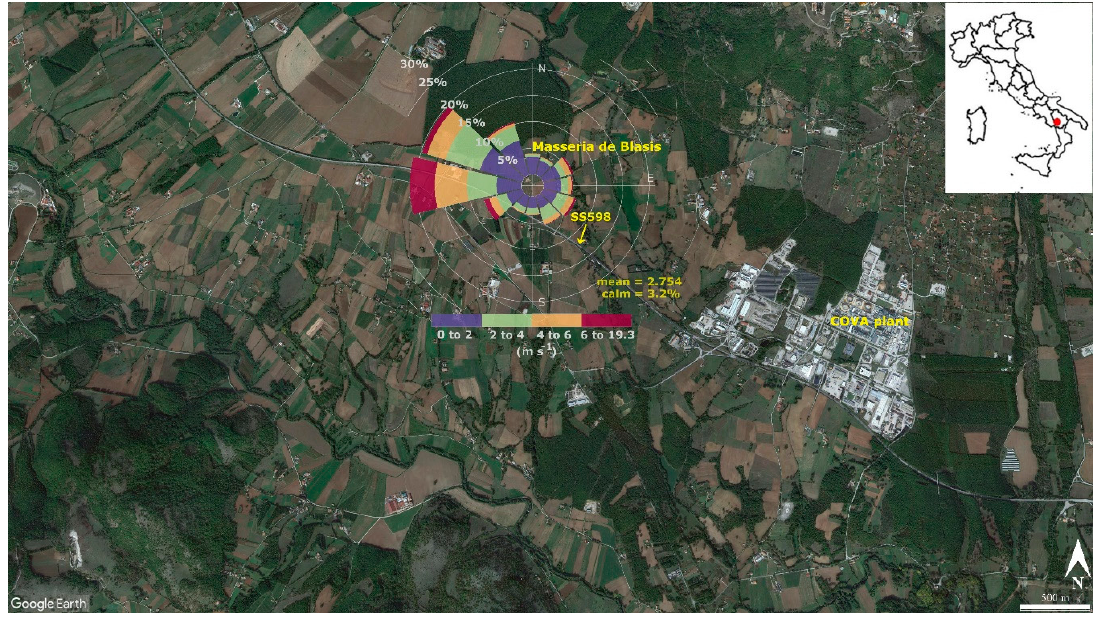
Figure 1. Map of the study area: the Masseria de Blasis (MdB) monitoring site, the Centro Oli Val d’Agri (COVA) plant, and the wind rose based on the hourly data at the MdB station over the study period (2016–2018).